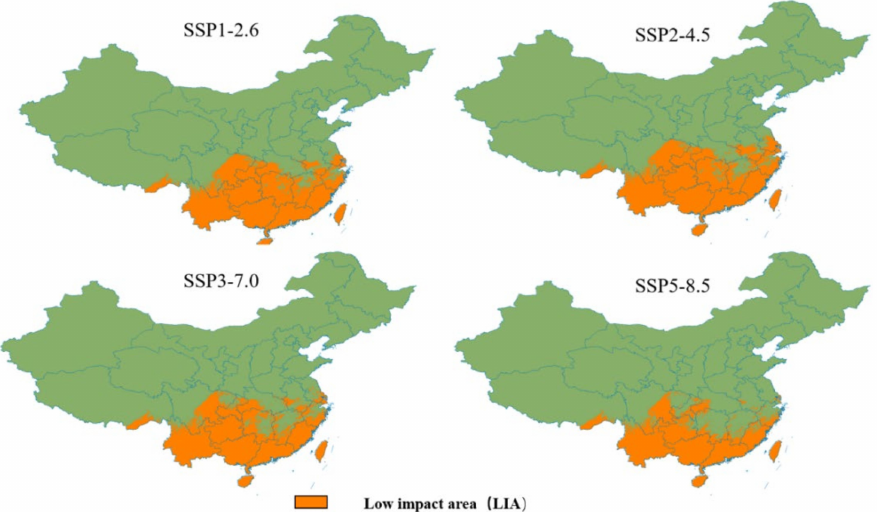
Figure 8. Prediction of low-impact areas (LIAs) for W. auropunctata under climate